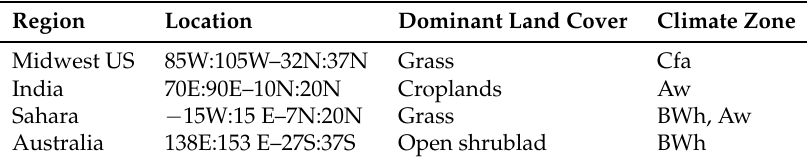
Figure 9. Shortened time series of CYGNS and SMAP soil moisture retrievals and in-situ measurements from the KnoxCity station. Table 3. Information on selected regions for spatial and temporal analysis (see Figure 1 for locations of these regions on the